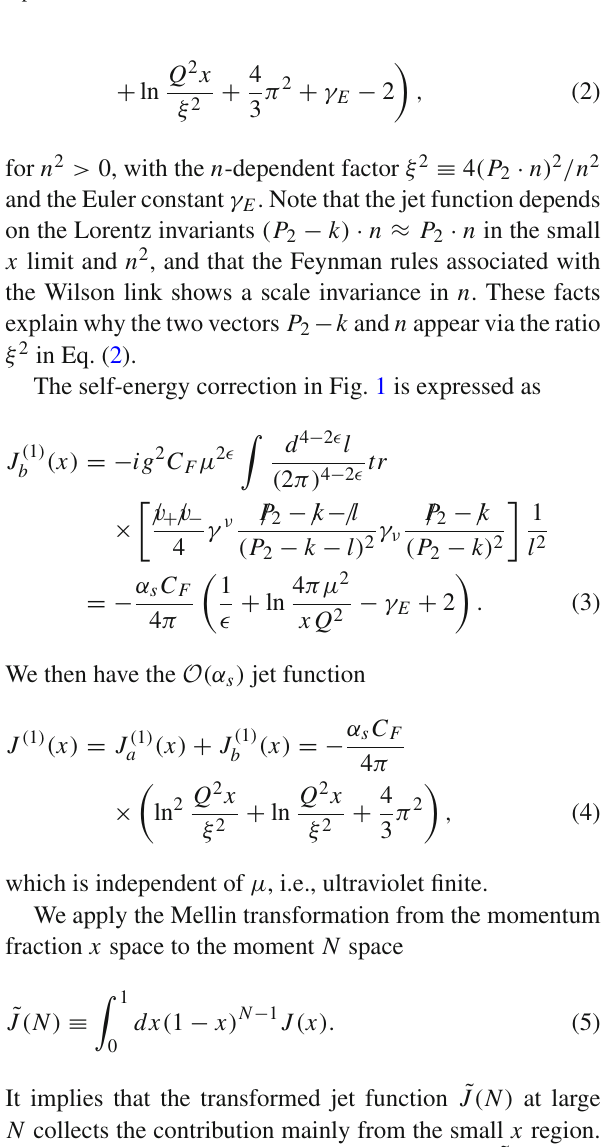
Fig. 1 One-loop diagrams for the jet function, where the double line represents the Wilson